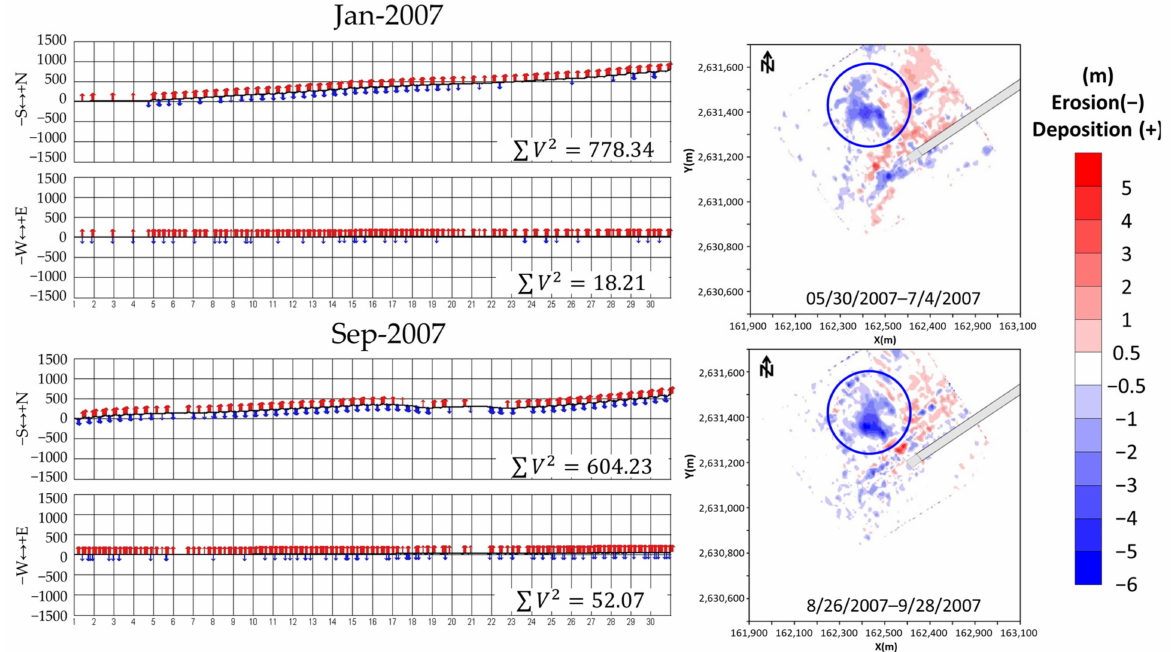
Figure 17. The cumulated energy at station YLCW and topographic change near the West Breakwater in summer (one-month